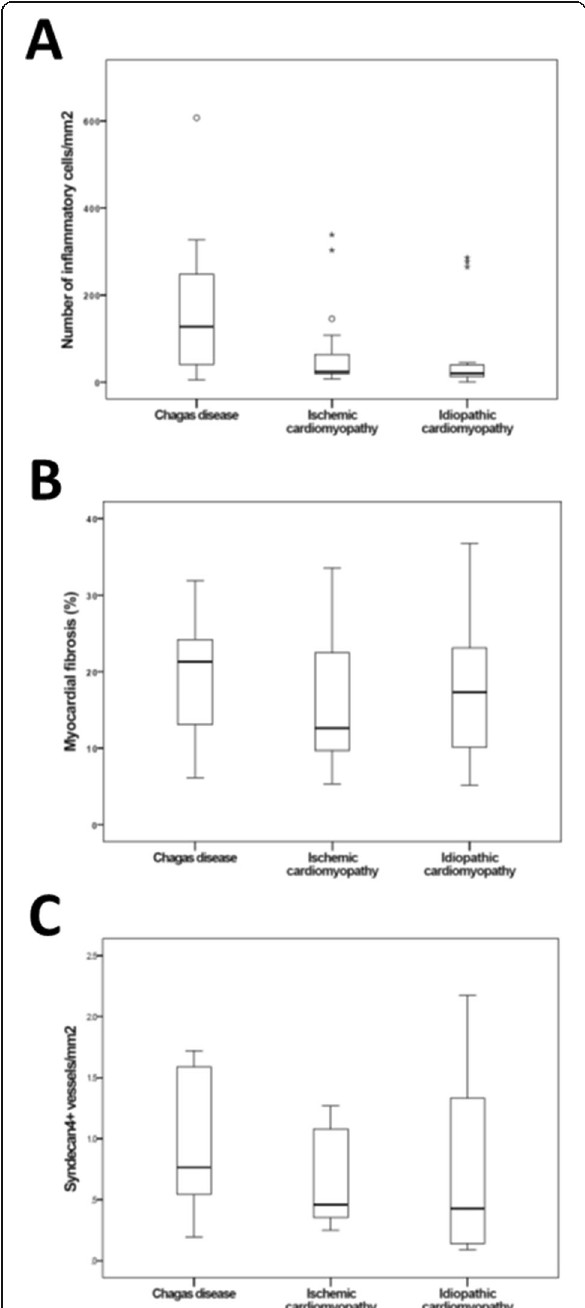
Fig. 6 Comparison of inflammation, fibrosis and syndecan-4 expression in the hearts of subjects with end-stage cardiomyopathy. Heart samples of subjects with Chagas disease ( n =7), ischemic cardiomyopathy ( n =5) and idiopathic dilated cardiomyopathy ( n =8). a , Number of inflammatory cells/mm 2 (Kruskal-Wallis one-way analysis of variance, P =0.035). b , Percentage of myocardial fibrosis (ANOVA, P =0.610). c , Number of syndecan-4 + blood vessels/mm 2 (Kruskal-Wallis one-way analysis of variance, P